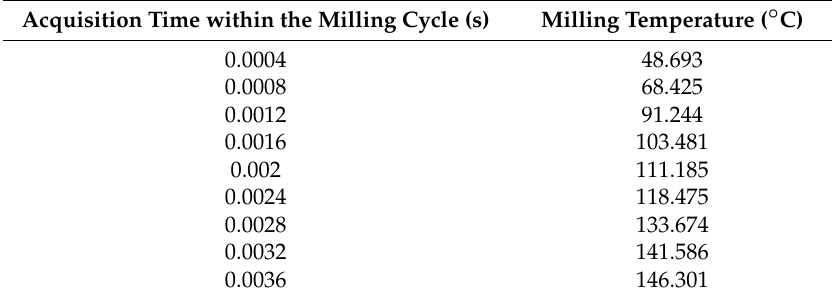
Table 2. Milling temperature data acquired across the milling cycle.